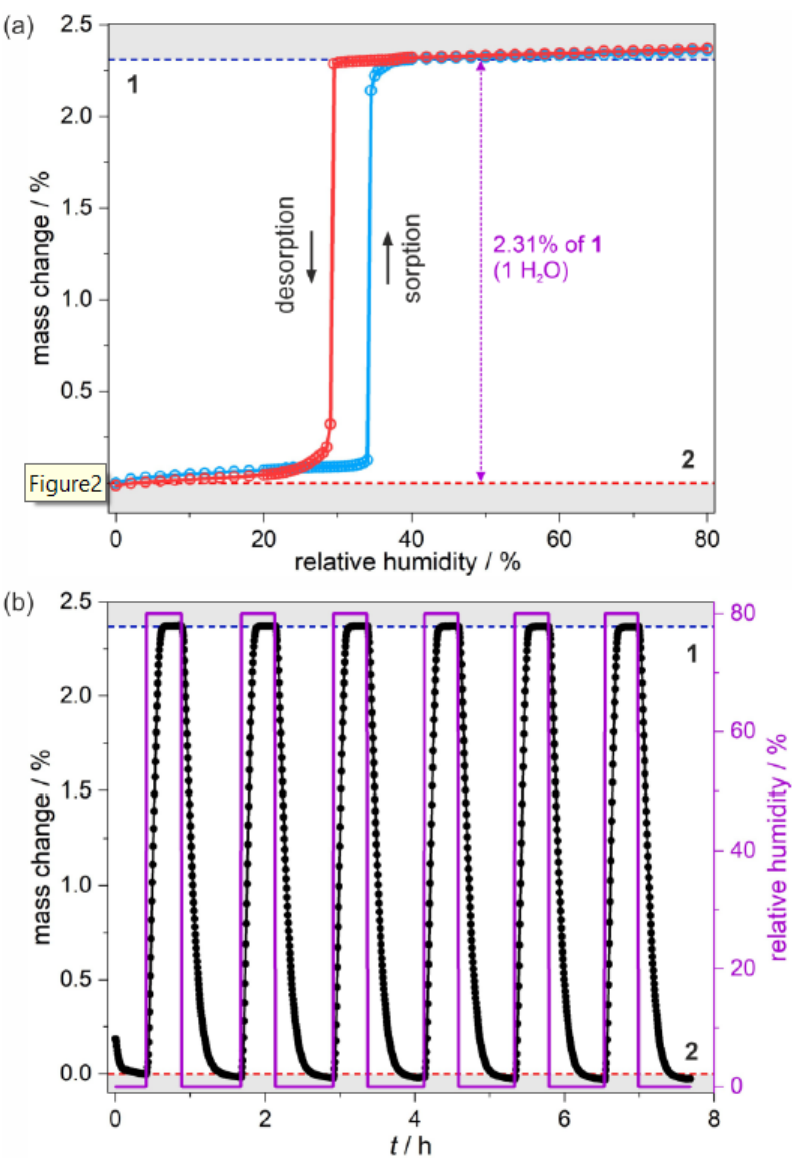
Figure 2. Room-teFigmperature humidity-driven switching between 1 and 2 illustrated by dynamic vapor sorption experiments: water sorption (blue line) and desorption (red line) isotherms measured at 298 K with the indicated mass change (violet arrow) ( a ), and the related hydration/dehydration cycles ( b ), both performed in the 0–80% range of the relative humidity. In ( b ), black and violet curves represent changes in the sample mass and the humidity level,